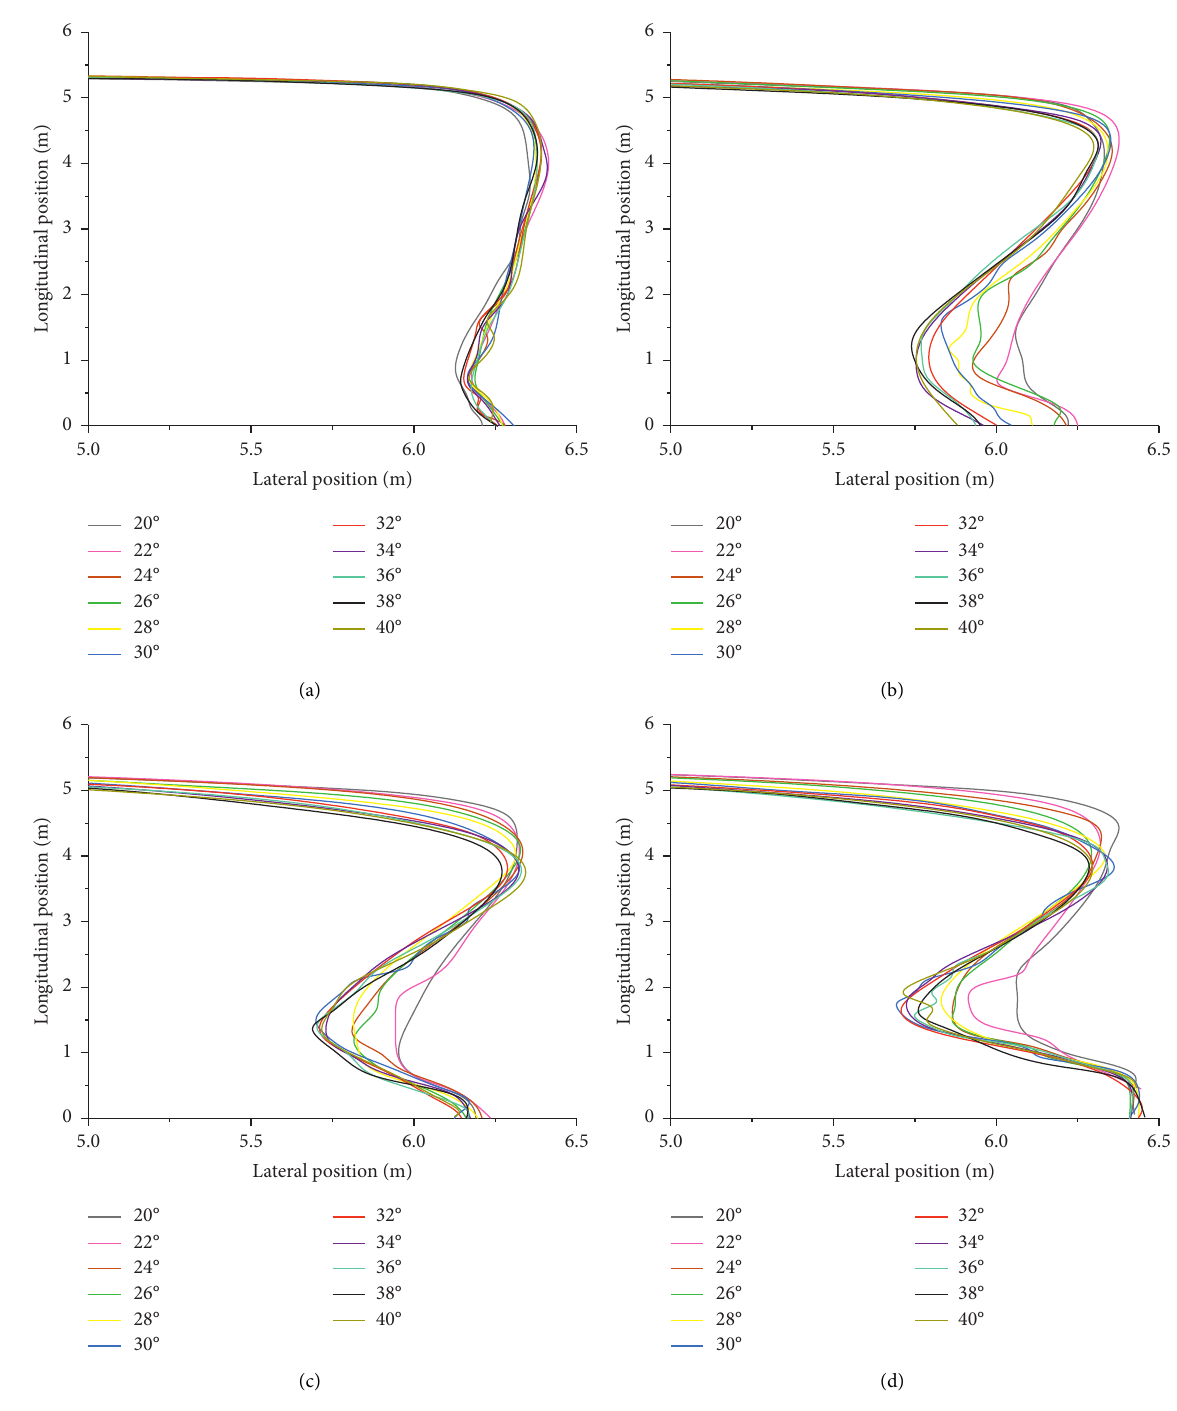
Figure 6: Comparison curve of the coal gangue boundary at different angles. (a) The boundary curve at 3s. (b) The boundary curve at 5s. (c) The boundary curve at 7s. (d) The boundary curve at 9